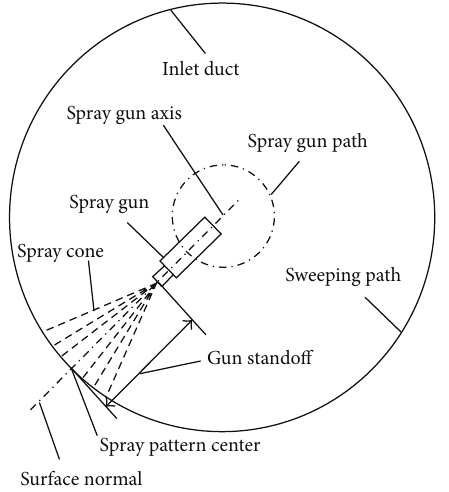
Figure 1: Basic principle of painting task